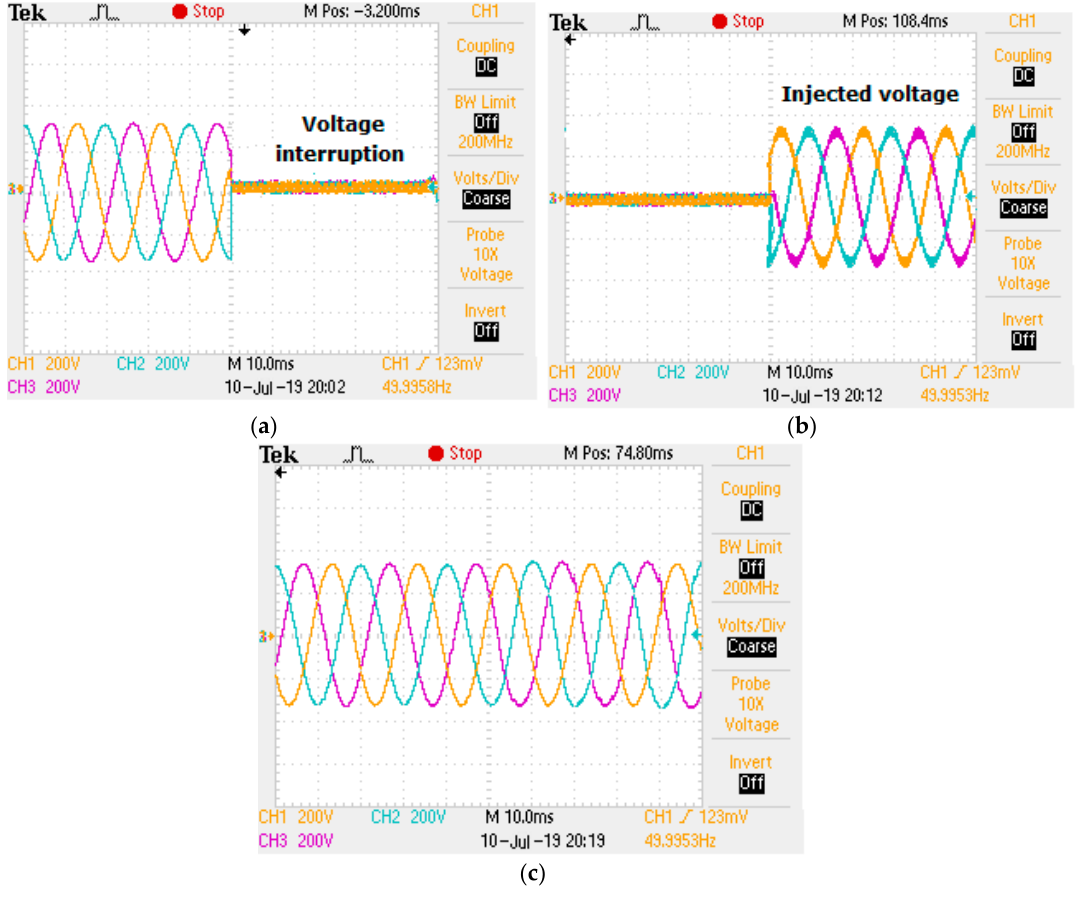
Figure 22. Experimental validation during a voltage interruption: (a) supply voltage; (b) injected voltage for compensation; and (c) load voltage after compensation of voltage interruption.